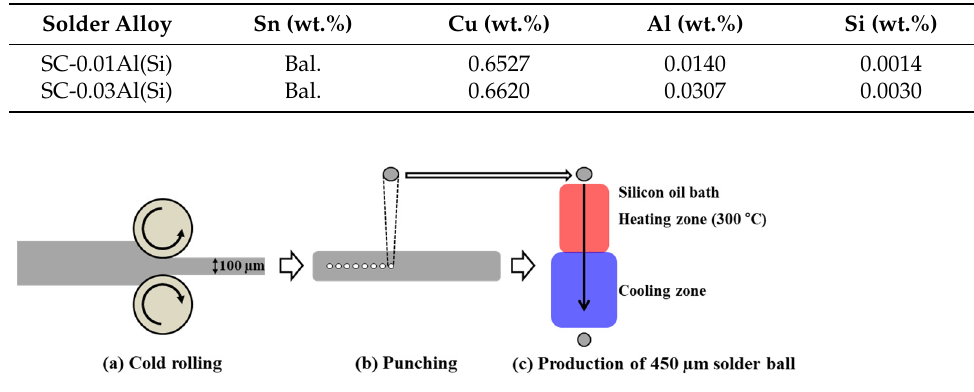
Figure 1. Schematic diagram of the solder ball manufacturing